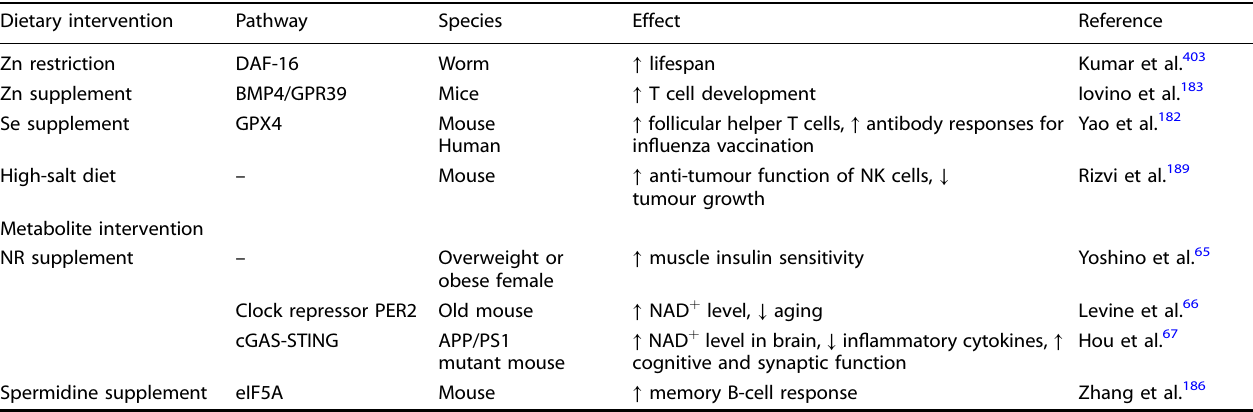
Nutrient-mediated mechanisms Metabolic